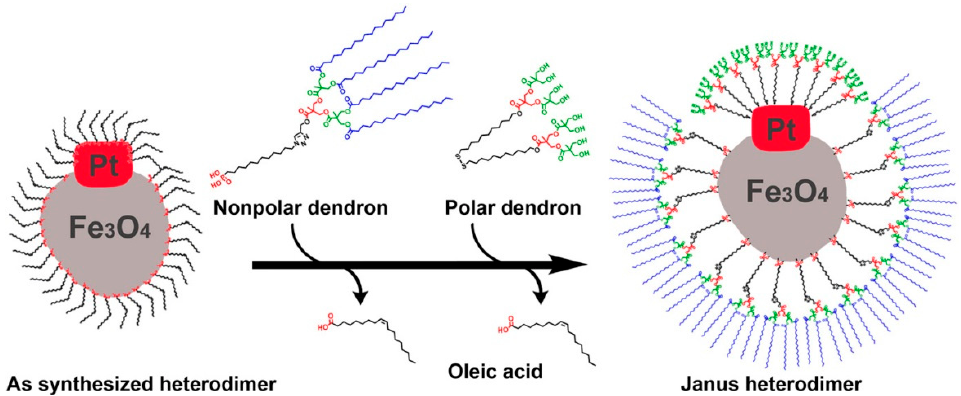
Figure 4. Schematic representation of the two-step ligand exchange process using dendritic ligands 7 and 6. Reprinted from Reference [29] with permission.